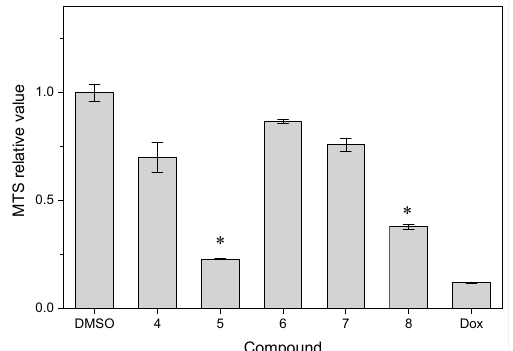
Figure 2. The MTS relative values of compounds 4 to 8 were compared with the vehicle control (DMSO) and the positive control (doxorubicin, Dox). * compounds with MTS relative values <0.40. Table 3. Cytotoxicity of compound 5 against three human carcinoma cell lines † . Cell Line